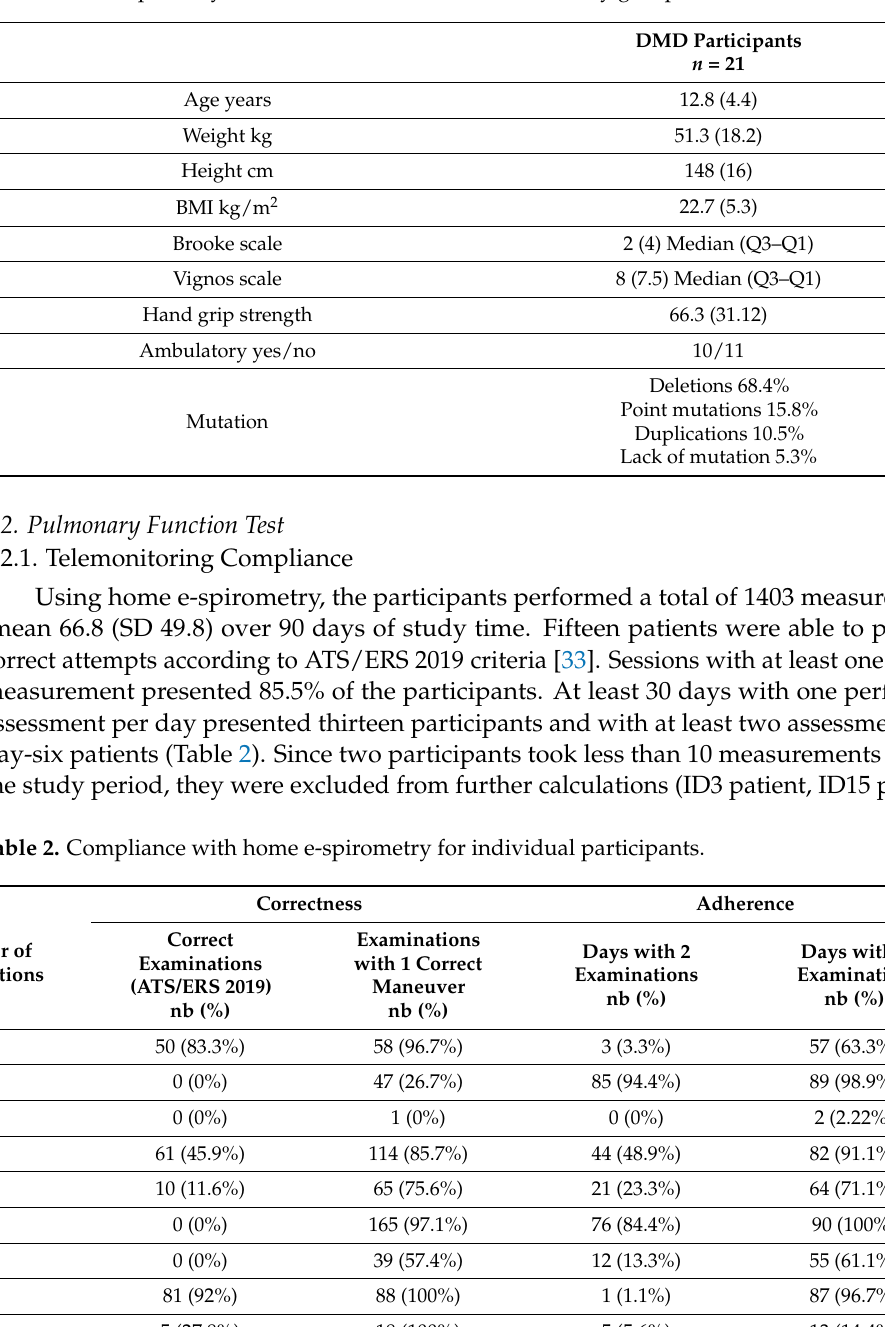
Table 1. Anthropometry and clinical characteristics of the study group.